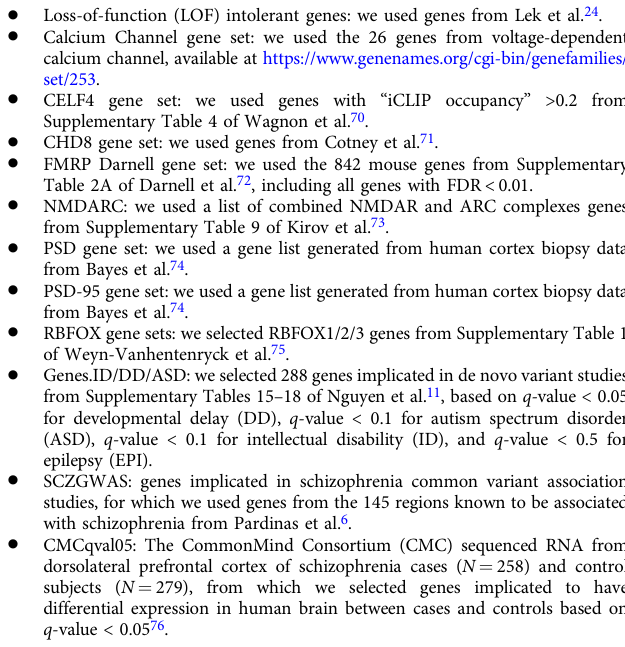
from Supplementary Table 9 of Kirov et al. 73 . ● PSD gene set: we used a gene list generated from human cortex biopsy data from Bayes et al. 74 . ● PSD-95 gene set: we used a gene list generated from human cortex biopsy data from Bayes et al. 74 . ● RBFOX gene sets: we selected RBFOX1/2/3 genes from Supplementary Table